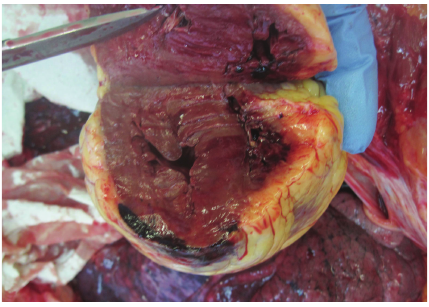
Figure 1: Transmural